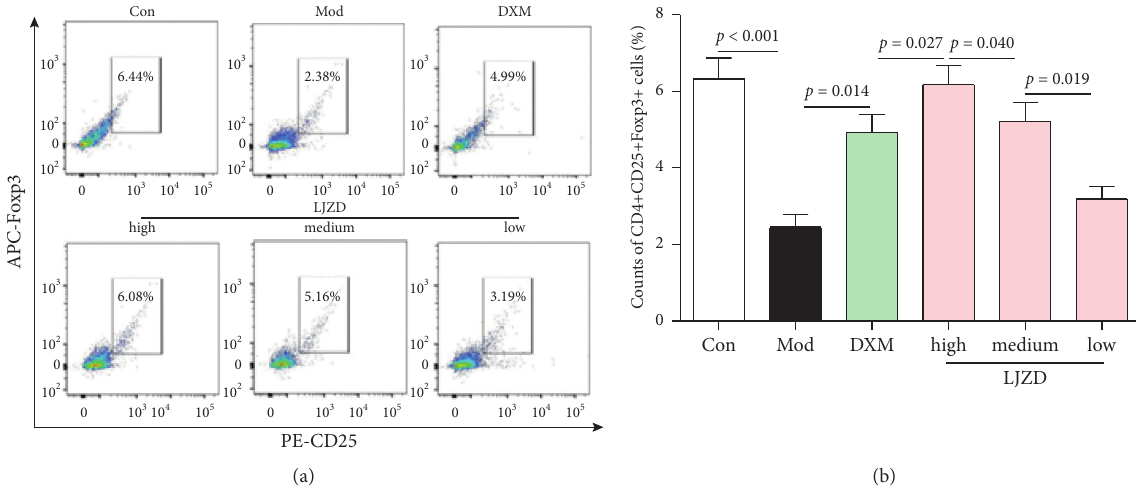
Figure 2: The representative images (a) and amounts (b) of CD4 + CD25 + Foxp3 + cells in the Con, Mod, DXM, and high-, medium-, and low- dosage LJZD groups by combining fluorescent antibody staining with flow cytometry